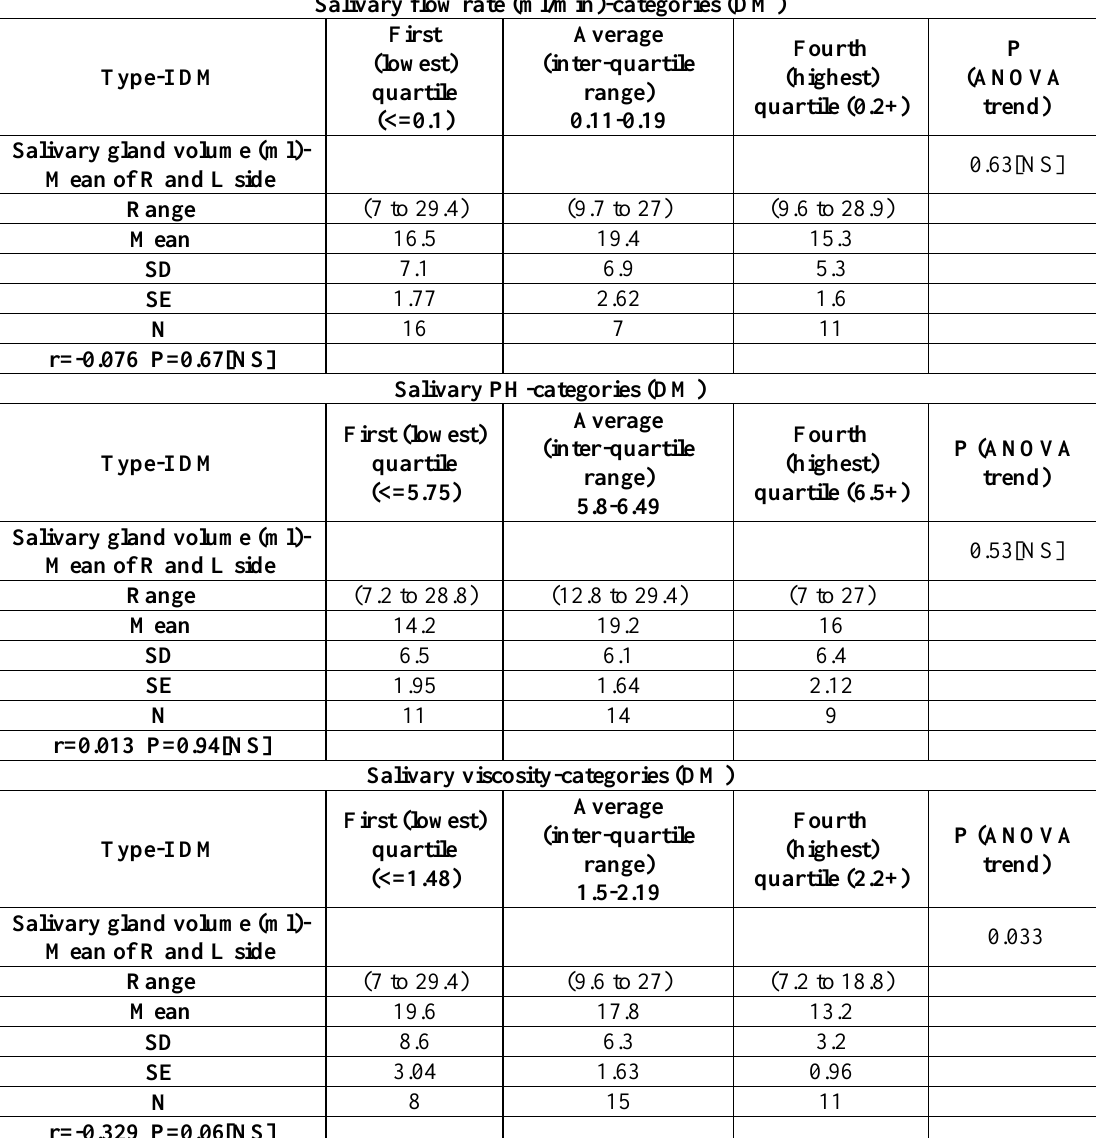
Table 3: The association between the physical properties of saliva with the SG measurements in Type I